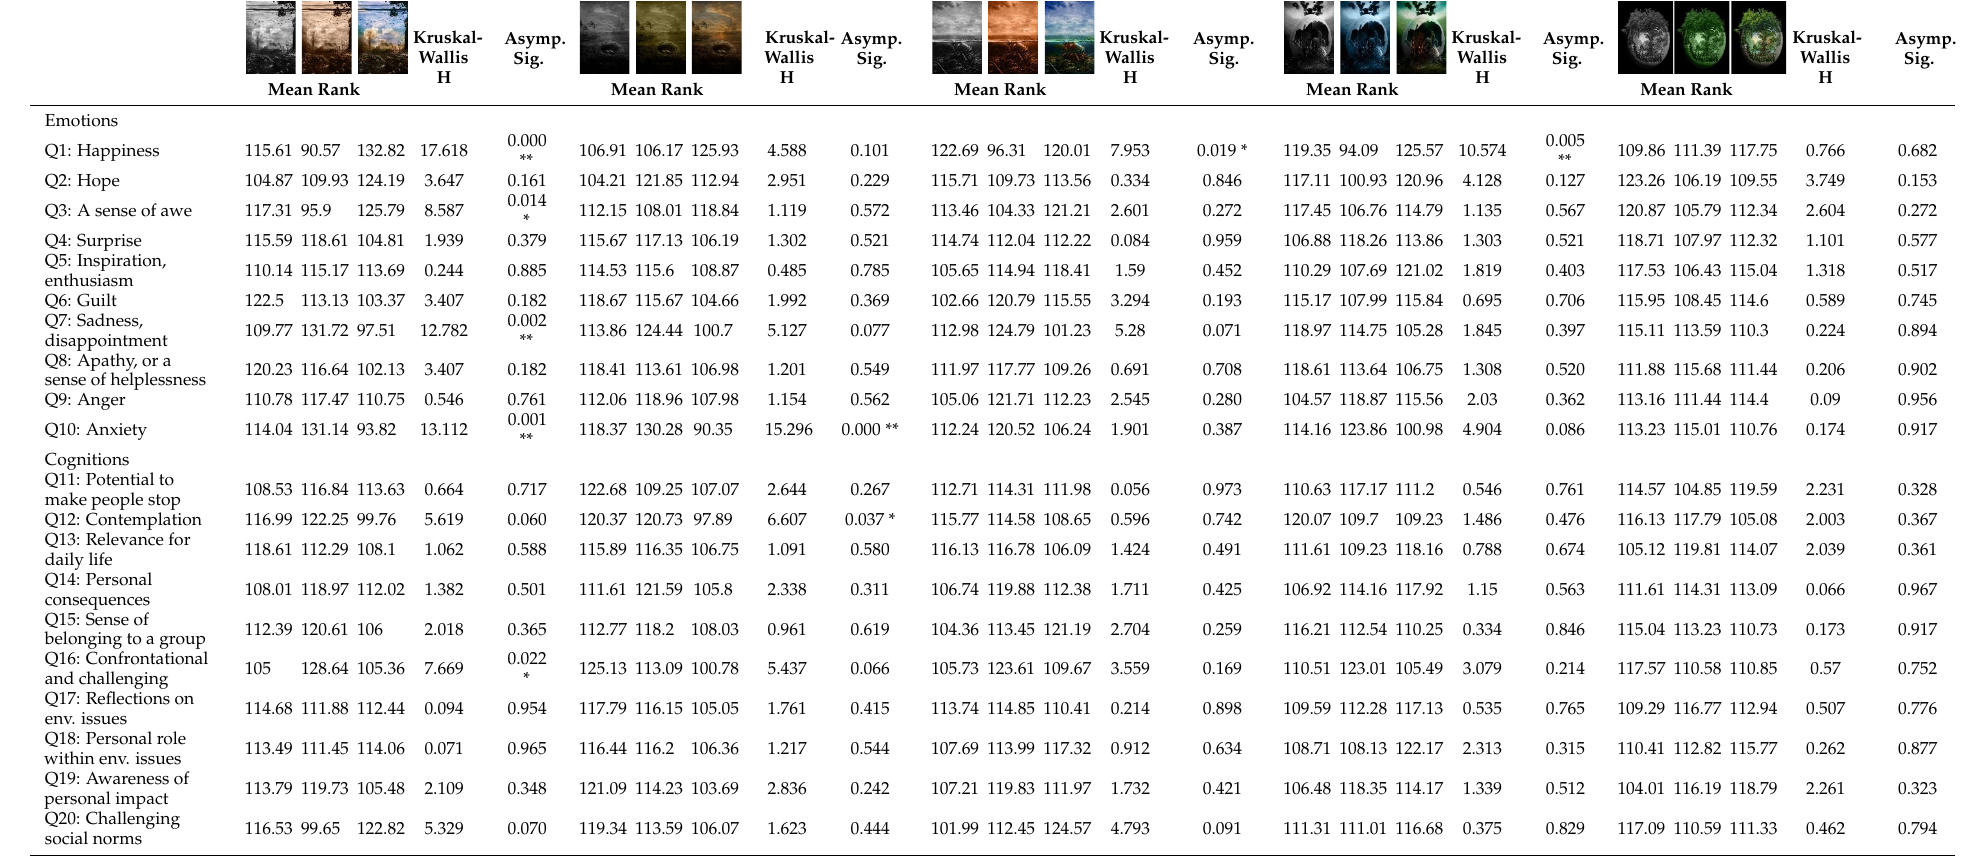
Table 2. The Kruskal–Wallis H test results of emotions and cognitions according to different types of color (sig. * p < 0.05, ** p <